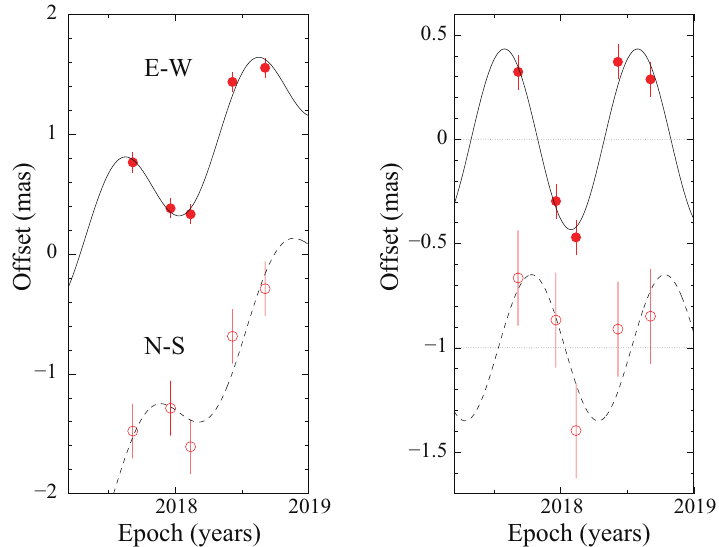
Figure 7. Results of parallax measurement and proper-motion fitting for a star-forming region W3(OH). The position offsets of W3(OH) are plotted with respect to the background quasar J0244 + 6228 in the east ( α cos δ ) and north ( δ ) directions as a function of time. For clarity, the north direction data is plotted offset from the east direction data. ( Left ) The best-fit models in the east and north directions are shown as continuous and dashed curves, respectively. ( Right ) Same as the left panel, but the component of proper motion is